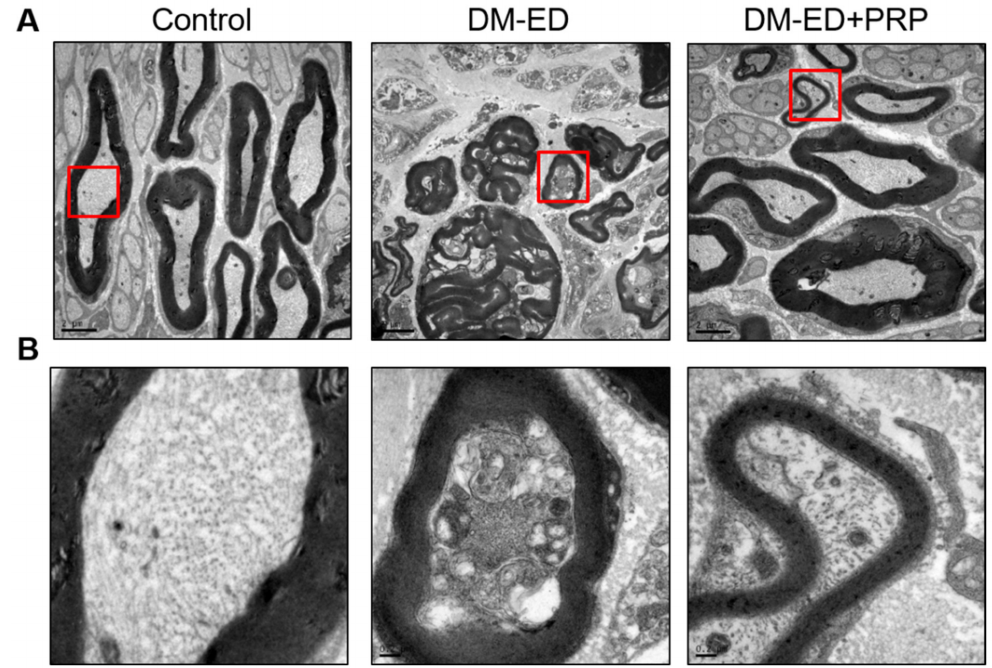
Figure 9. Transmission electron microscopy (TEM) of the cavernous nerve in 5000 × ( A ) and 30,000 × ( B ) magnifications of the red-coloured demarcated area from ( A ). DM-ED, streptozotocin (STZ)-induced diabetes mellitus (DM) with erectile dysfunction (ED) and treated with saline; DM-ED + PRP, STZ- induced DM with ED and treated with platelet-rich-plasma. (Scale: ( A ): 2 µ m; ( B ): 0.2 µ